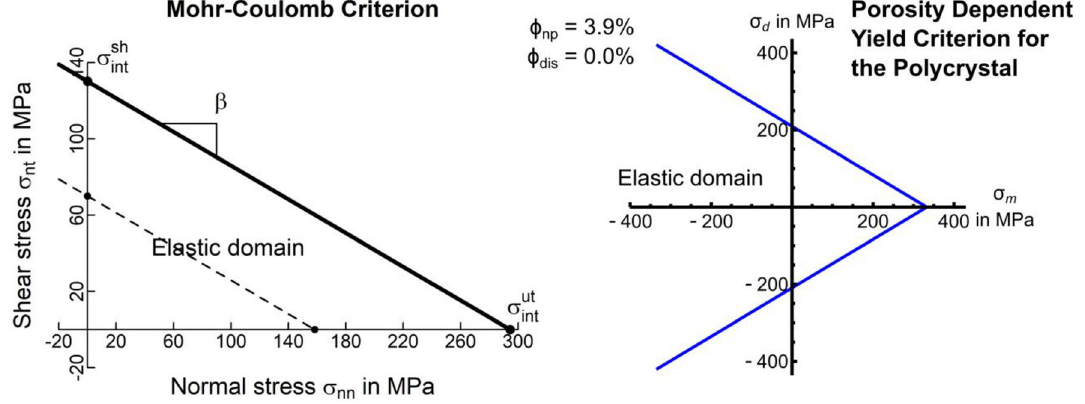
Figure 4. Yield criteria for the cold-water coral skeleton: Left image shows an interfacial Mohr–Coulomb criterion (Eq. 3) of the aragonite crystals using interfacial tensile σ ut int and shear σ sh int strengths based on micropillar tests (solid line) as well as for nacre aragonite interfacial strengths (dashed line). Right image shows a porosity dependent quadric yield criterion 61 plotted along its trisectrix with mean stress σ m and deviatoric stress σ d . The criterion can incorporate increasing porosities (Fig. 7) due to acidification and erosion processes and is plotted here with no dissolution porosity φ dis . Since its material parameters are derived from the underlying 3.9% polycrystal elasticity and crystalline yield behaviour, its parameters contain a φ np = n n n and σ t σ σ σ nn Arag (ϕ , θ) · nt = Arag (ϕ , θ) · = · · (5)